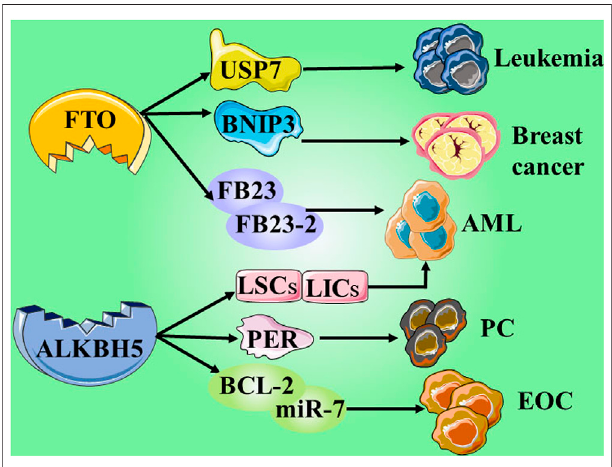
FIGURE3 | Give examples ofthe role and mechanisms involved erasers in